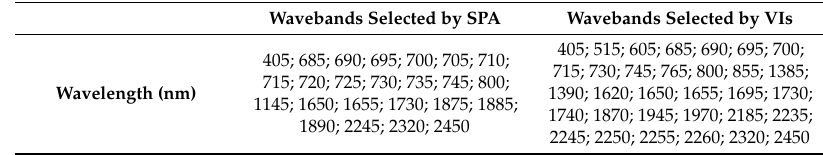
Table 4. The wavebands selected by SPA and vegetation indexes (Vis) with high